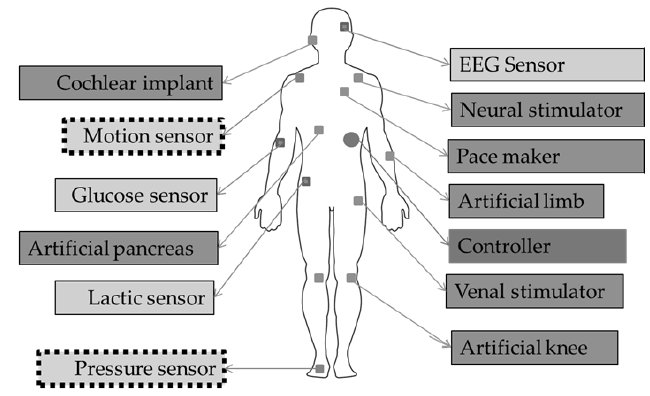
Figure 3. An example of heterogeneity of nodes in